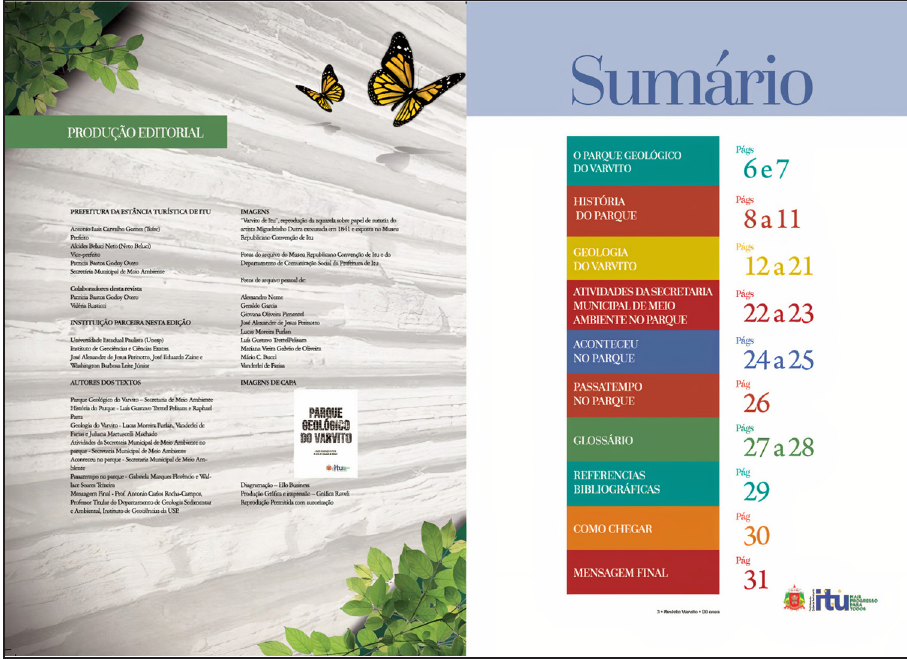
FIGURE 6 . Summary of the commemorative edition of 20 years of the Park (2015) of Parque do Varvito Magazine (Itu